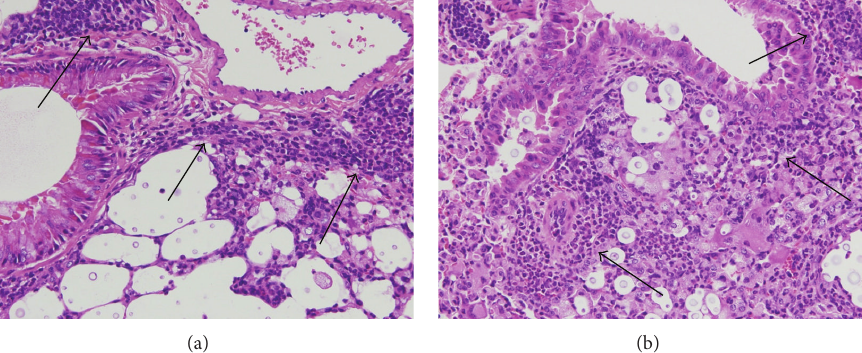
Figure 7: (a) Pulmonary sections of mice infected with C. gattii R265 exhibited poor neutrophil recruitment around the bronchovascular structures (arrowheads, hematoxylin and eosin (HE) double stain, and × 400). (b) Pulmonary sections of mice infected with C. neoformans H99 showed extensive neutrophil recruitment around the bronchovascular structures (arrowheads, HE double stain, and × 400).